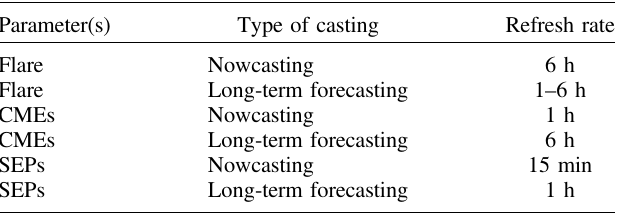
Table 2. List of the RPF 1 products along with the casting type and the refresh